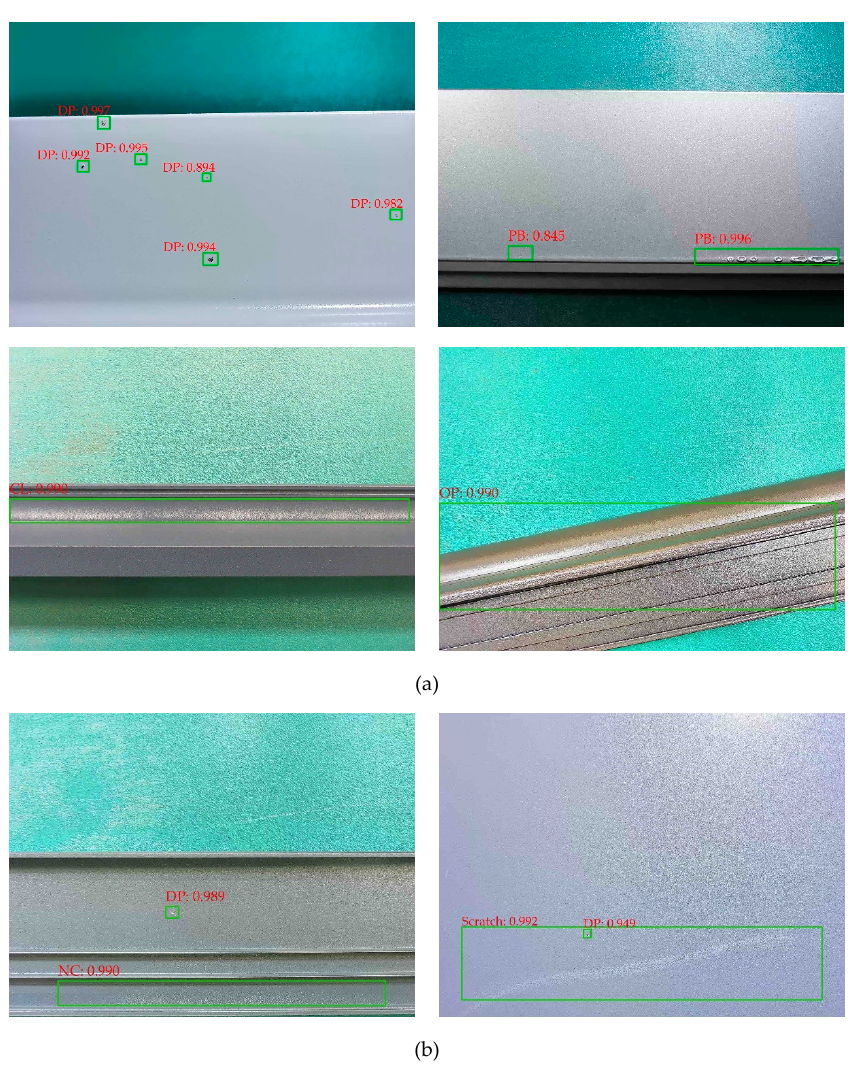
Figure 12. ( a ) Images with a single type of defect; ( b ) images with multiple types of